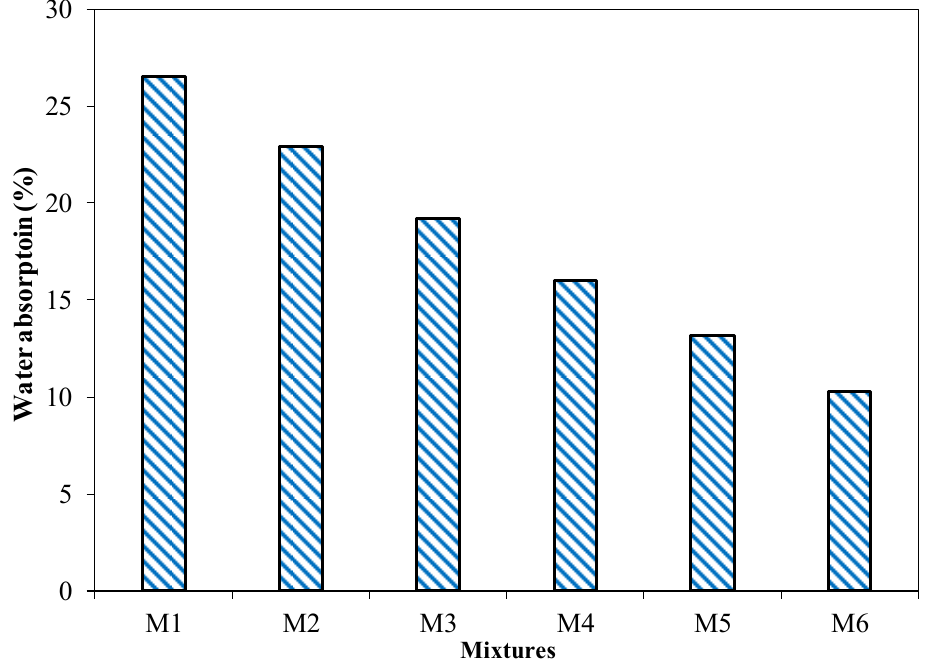
Figure 13. Water absorption of the brick specimens according to the percentage of cement.